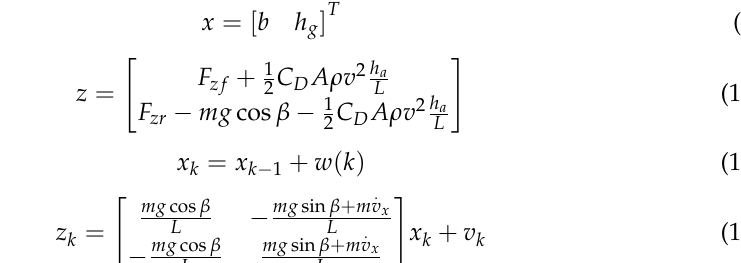
( b ) Figure 8. Estimation results of the center of gravity position of the vehicle at full load. ( a ) Distance from the center of gravity position to the rear axis; ( b ) height of the center of gravity.